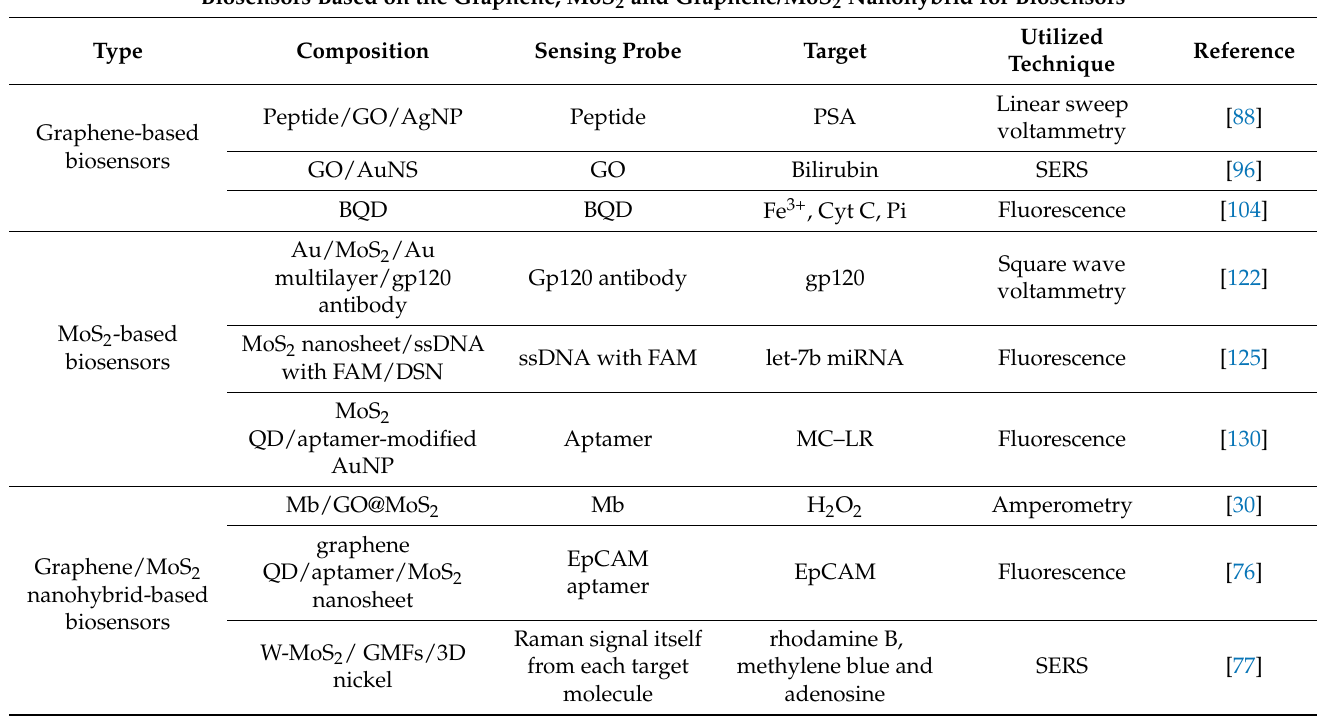
Table 1. Comparison and characteristics of graphene, MoS 2 , and the graphene/MoS 2 nanohybrid utilized in highly sensitive